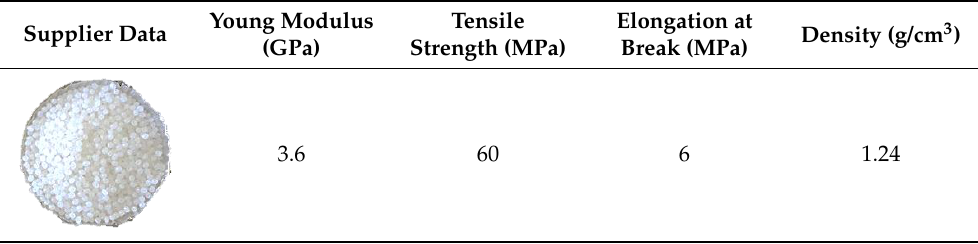
Figure 4. Bundle of nettle fibers under the electron microscope.